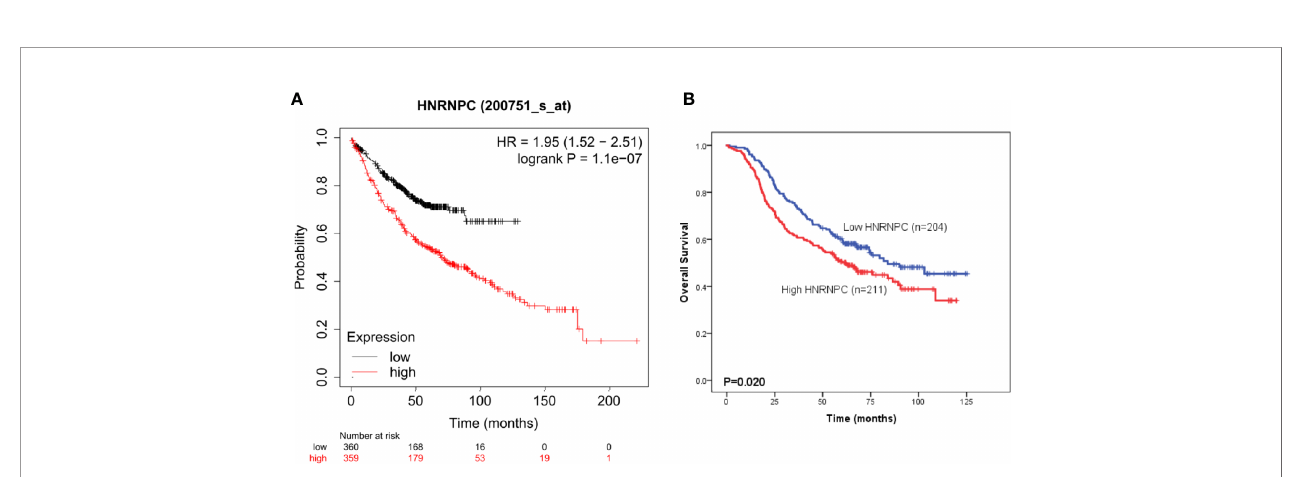
FIGURE 5 | High heterogeneous nuclear ribonucleoprotein C (HNRNPC) expression is signi fi cantly associated with poor overall survival (OS) of patients with lung adenocarcinoma (LUAD). (A) Kaplan-Meier survival analysis of the relationship between HNRNPC and OS using Kaplan-Meier plotter cohort data. (B) Kaplan-Meier survival analysis of the relationship between HNRNPC and OS using the National Cancer Center of China (NCC) cohort data.